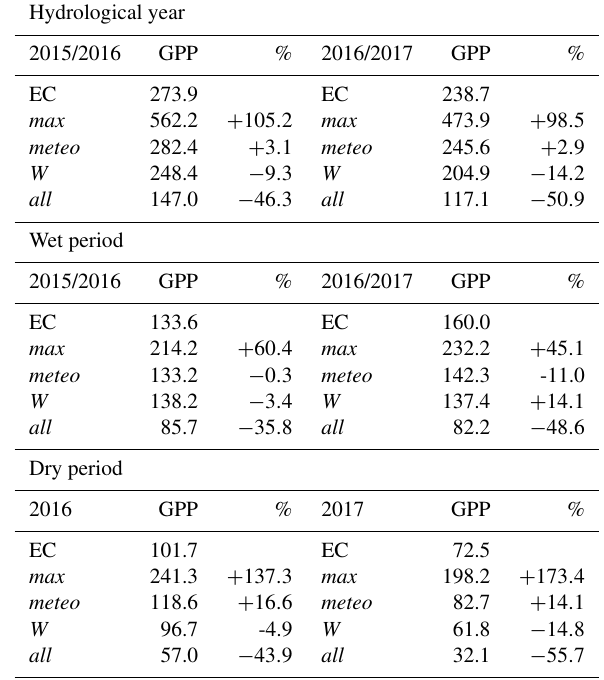
Table 2. Accumulated GPP (gm − 2 day − 1 ) for hydrological year and wet and dry period. The percentage represents the difference respect to EC